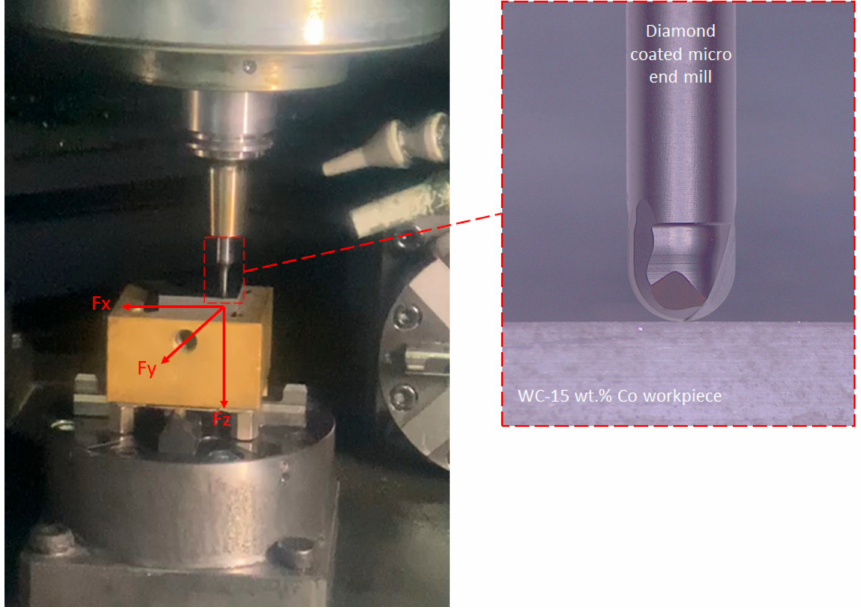
Figure 1. Setup used for machining of WC-15 wt.% Co with diamond-coated micro-end mill (inset).